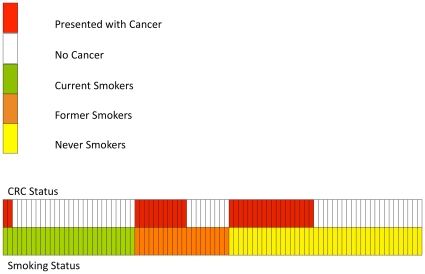
Schematic diagram of all female patients in the study with CRC and smoking status, showing the decreased odds of presenting with CRC in those currently smoking.